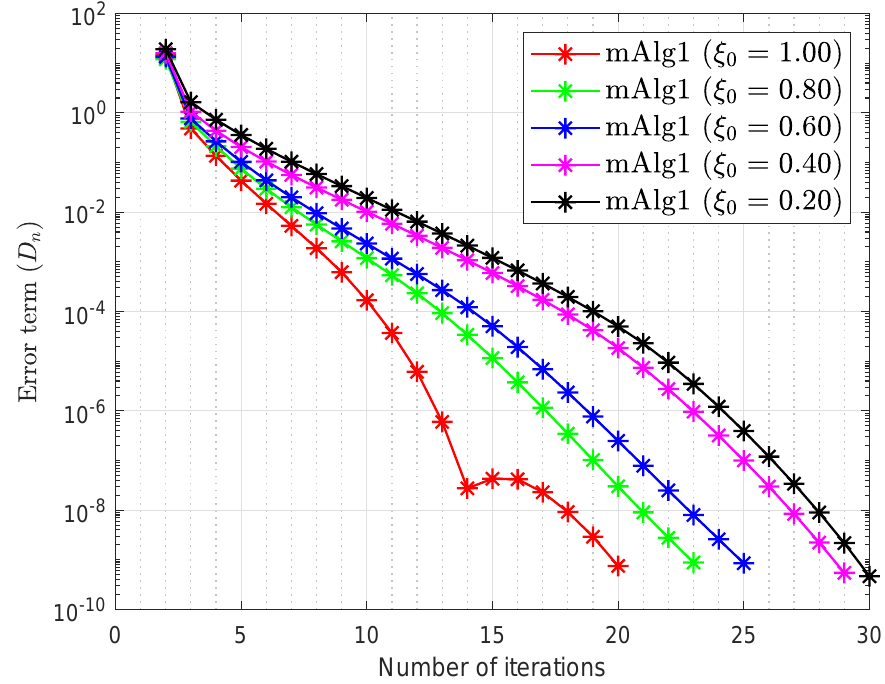
Figure 1. Example 1: numerical behaviour of Algorithm 1 by letting different options for ξ 0 , while m = 10.